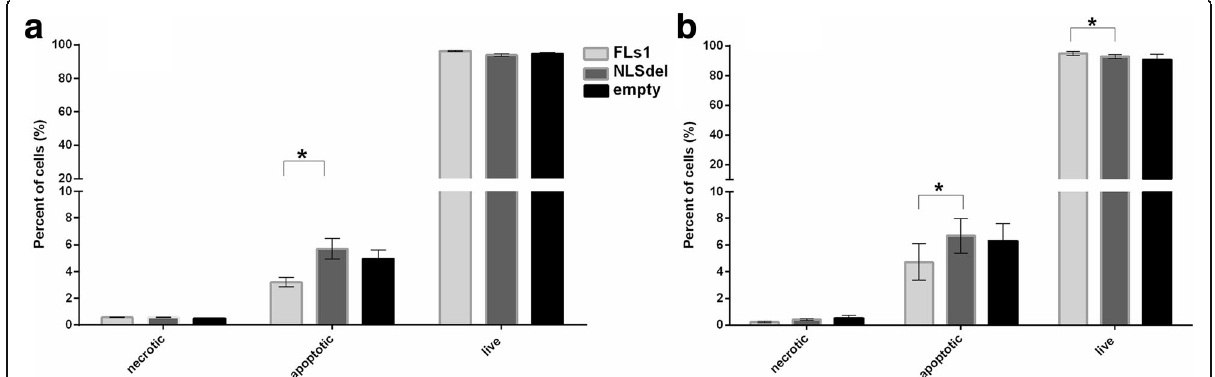
Fig. 3 Nuclear translocation of syndecan-1 affects the rate of apoptotic cells in fibrosarcoma cells. Histogram representing flow cytometry data of cells stained with Annexin-FITC and propidium iodide. The percentages of live, necrotic and apoptotic cells were measured at ( a ) 48 h and ( b ) 72 h after cell seeding. The fraction of apoptotic cells was significantly lower in cells transfected with full-length syndecan-1 (FLs1), at both time points, compared to cells transfected with syndecan-1 lacking the nuclear localization signal (NLSdel). Bars represent the average of three independent experiments ±SD. * P <0.05, based on the paired t-test